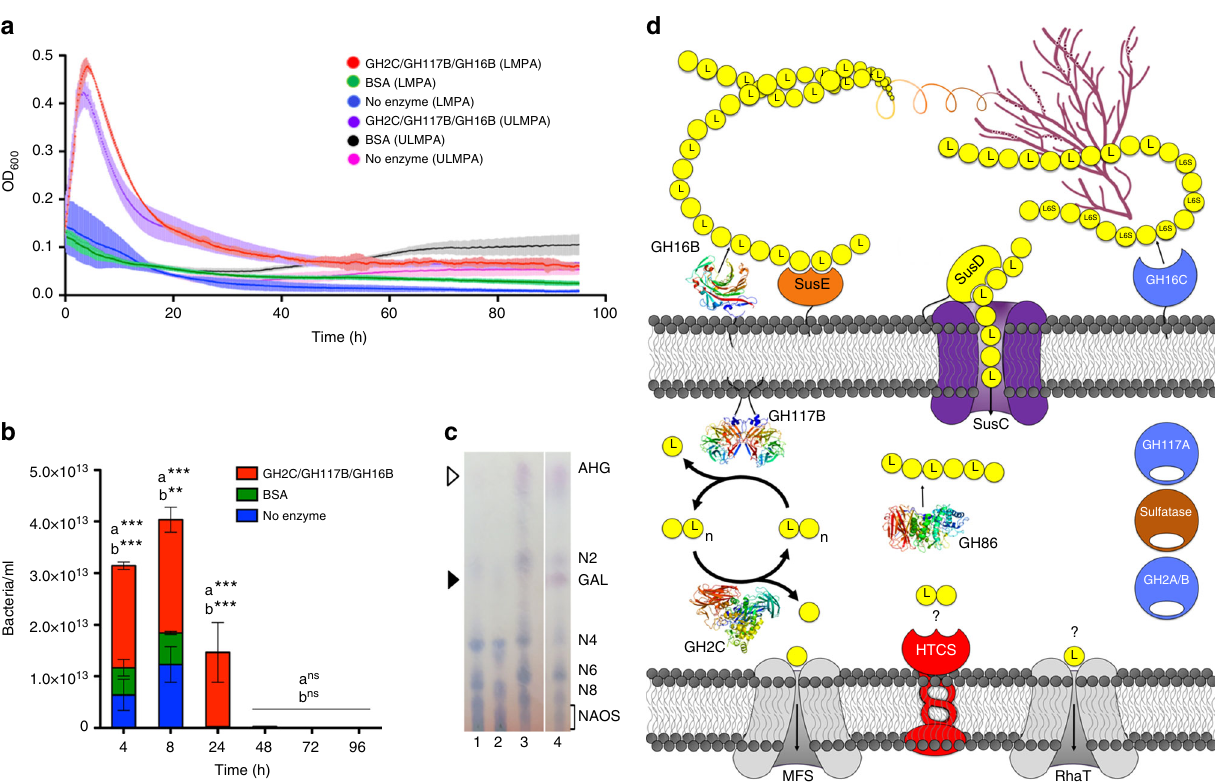
Fig. 6 Role of agarolysis in selective growth of intestinal Bu and architecture of the Ag-PUL. a Growth of Bu ATCC 8492 grown on 1% (w/v) LMPA or ULPMA with growth medium supplemented with GH2C, GH117B, and GH16B. Error (s.d.) is represented by the thickness of the trace over three biological replicates, with six independent measurements per replicate. b Quanti fi cation of bacterial growth on LMPA was monitored by colony forming units (bacteria/ml). Vertical lines associated with histogram bars represent s.e.m. ( n = 3); a enzymes to BSA, b enzymes to no enzyme; ** p < 0.01, *** p < 0.001. c TLC analysis of the spent supernatant fractions following growth of agarolytic and non-agarolytic Bu strains on LMPA and ULMPA (representative replicates). Lane 1, Bu NP1 growth on LMPA, Lane 2, Bu NP1 growth on ULMPA, Lane 3 , Bu ATCC 8492 on LMPA supplemented with GH2C, GH117B, and GH16B, and Lane 4, LMPA digestion control with GH16B, GH117B, and GH2C (no cell control). d Schematic model of the agarolytic pathway. Locations are based upon signal peptides listed in Supplementary Table 1. Initial depolymerization of agarose and porphyran occurs at the outer surface of Bu NP1 by the activity of GH16B and GH16C, respectively. The extracellular recruitment of agarose is facilitated by interactions with the SusE-like (NP1_9, orange) and SusD-like (NP1_10, yellow) proteins. Import of products occurs through the SusC-like transporter (NP1_11, purple). Within the periplasm, NAOS are further depolymerized to N2 by GH86; alternatively, NAOS can be sacchari fi ed by the exo -acting GH117B – GH2C cycle. Released GAL is imported into the cytoplasm through MFS proteins; AHG may have an alternative import pathway through the RhaT protein. Structurally characterized enzymes are shown in cartoon format color ramped from N terminus (blue) to C terminus (red), and predicted enzymes are displayed as